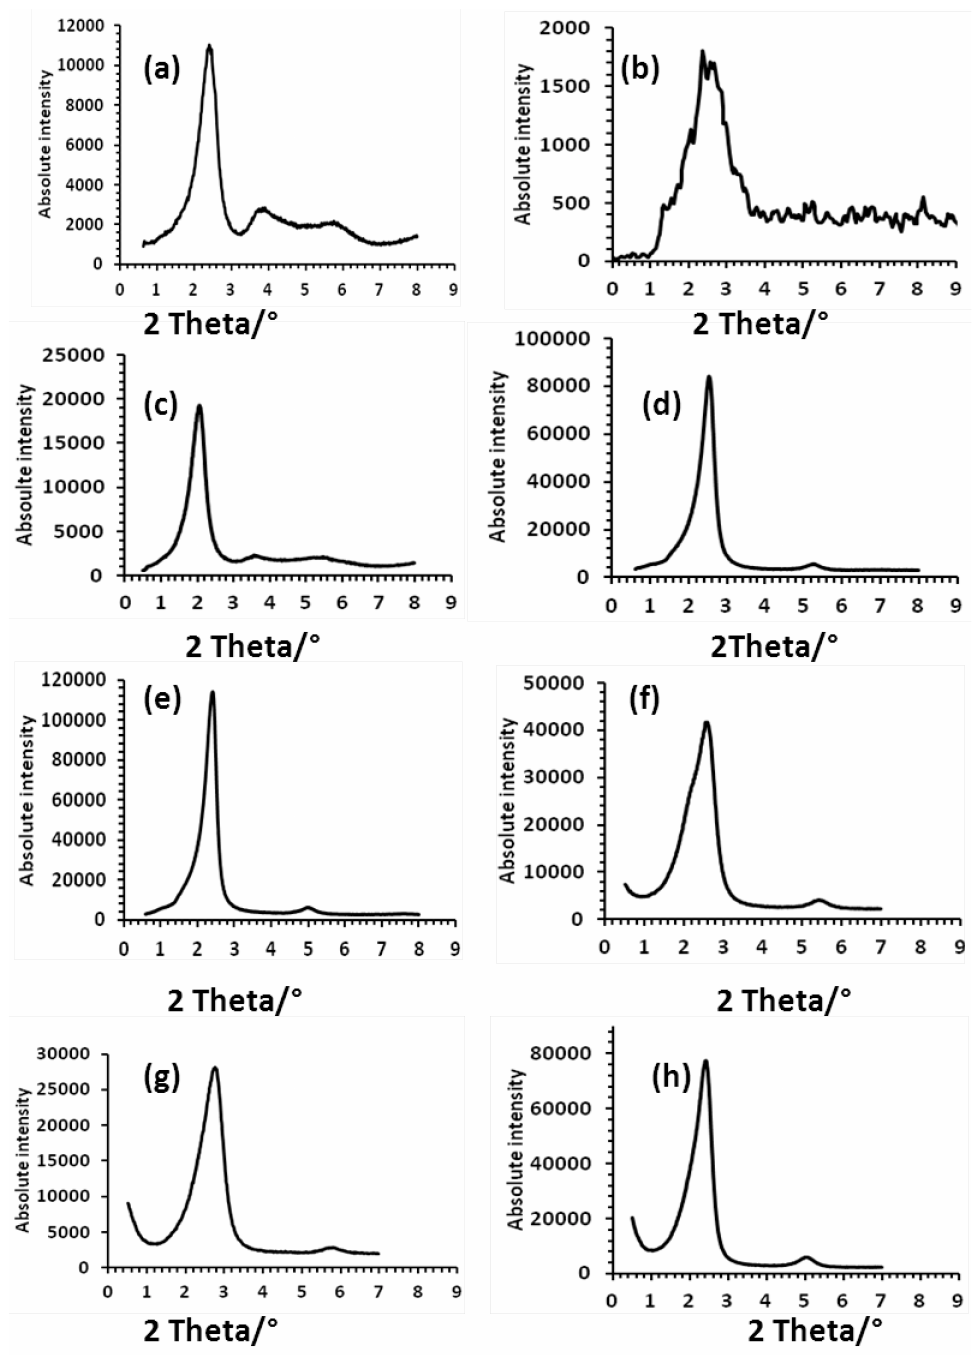
Figure 8. SA-XRD patterns recorded